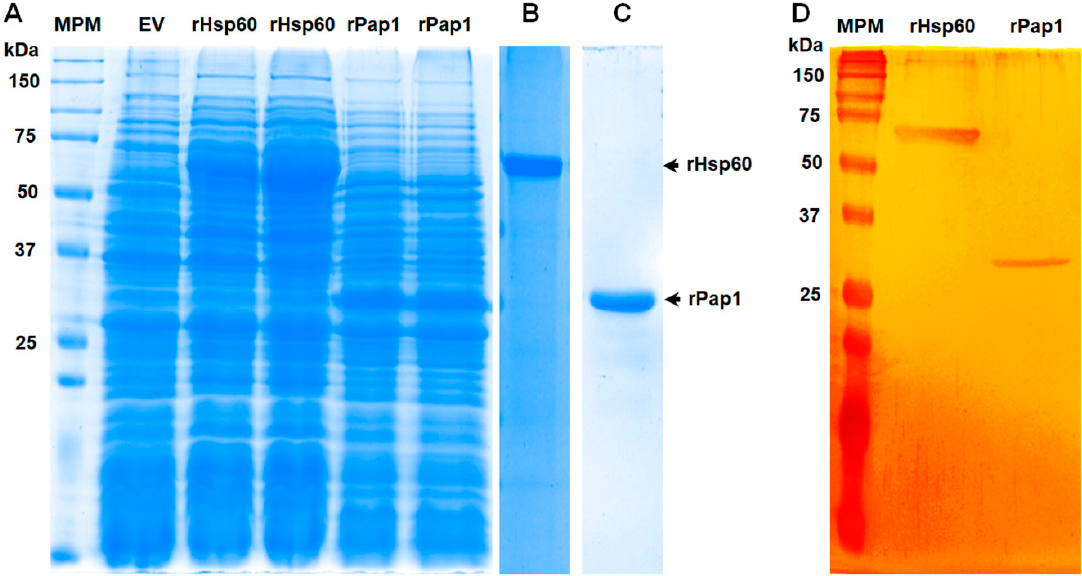
Figure 2. Expression of recombinant Hsp60 and Pap1 expressed in Escherichia coli . In ( A ), bacteria were transformed with pCold- HSP60 (rHsp60 lanes), pCold- PAP1 (rPap1 lanes), or the empty pCold I vector (EV) and grown under inducing condition (0.1 M isopropyl- β -D-1-thiogalactopyranoside and 20 h at 15 °C). Protein samples were prepared from cultured cells and separated by denaturing SDS-PAGE in 12% ( w / v ) gels. Two independent clones for production of each recombinant protein were analyzed. The recombinant proteins were then subjected to purification as described in the main text and were either Commassie Blue-stained (( B , C ) correspond to purified rHsp60 and rPap1, respectively) or silver-stained ( D ). MPM, molecular protein marker.